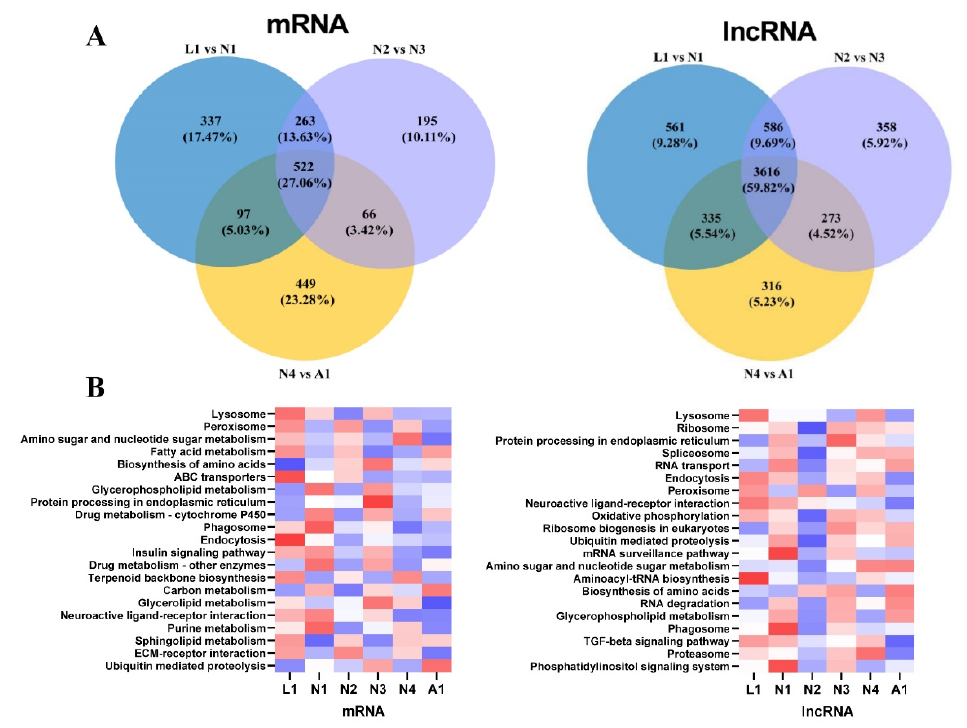
Figure 3. Expressed lncRNAs and mRNAs in the molting processes of different development stages in Panonychus citri . ( A ) Venn diagram of expressed lncRNAs and mRNAs in the molting processes of different development stages. ( B ) The top 21 enriched Kyoto Encyclopedia of Genes and Genomes (KEGG) pathways of long non-coding RNA (lncRNA) targets and mRNA transcripts in the molting processes of different development stages. L1: late larva; N1: early protonymph; N2: late protonymph; N3: early deutonymph; N4: late deutonymph; A1: early adult.